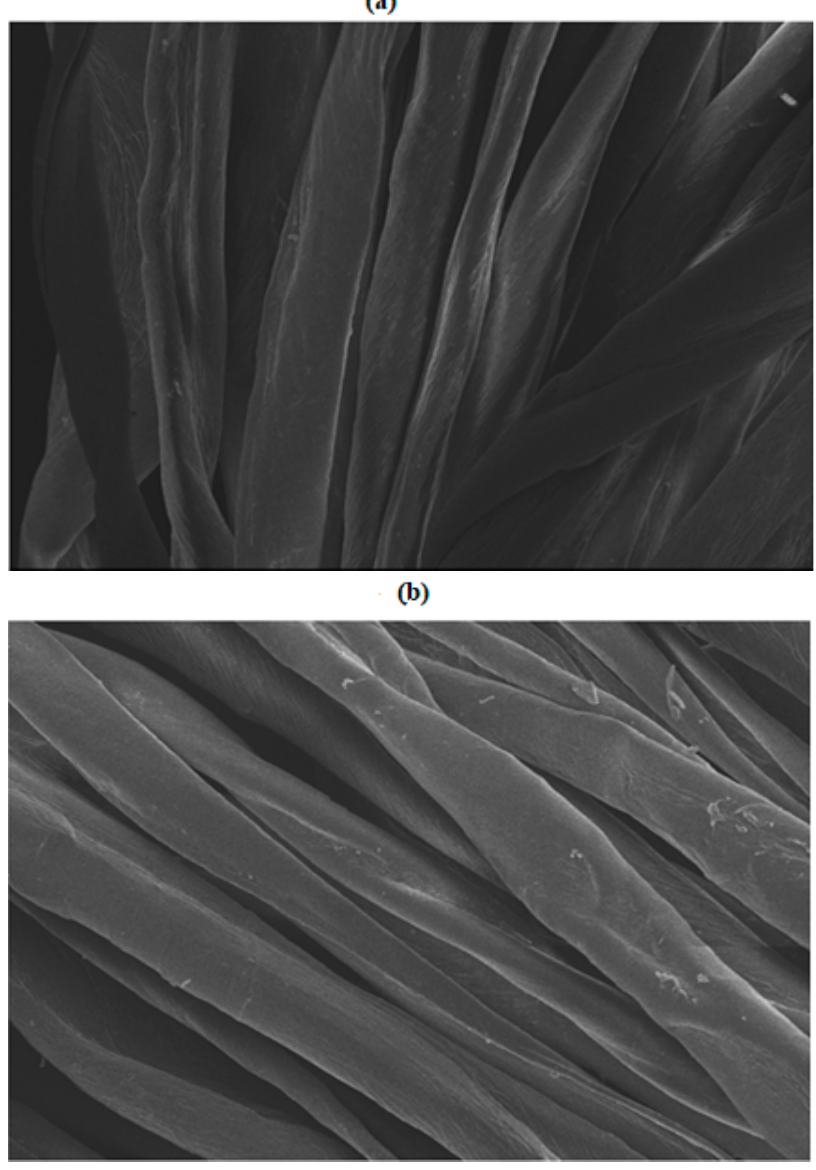
Figure 4. SEM analysis of ( a ) non-treated and ( b ) microwave treated cotton fabric.